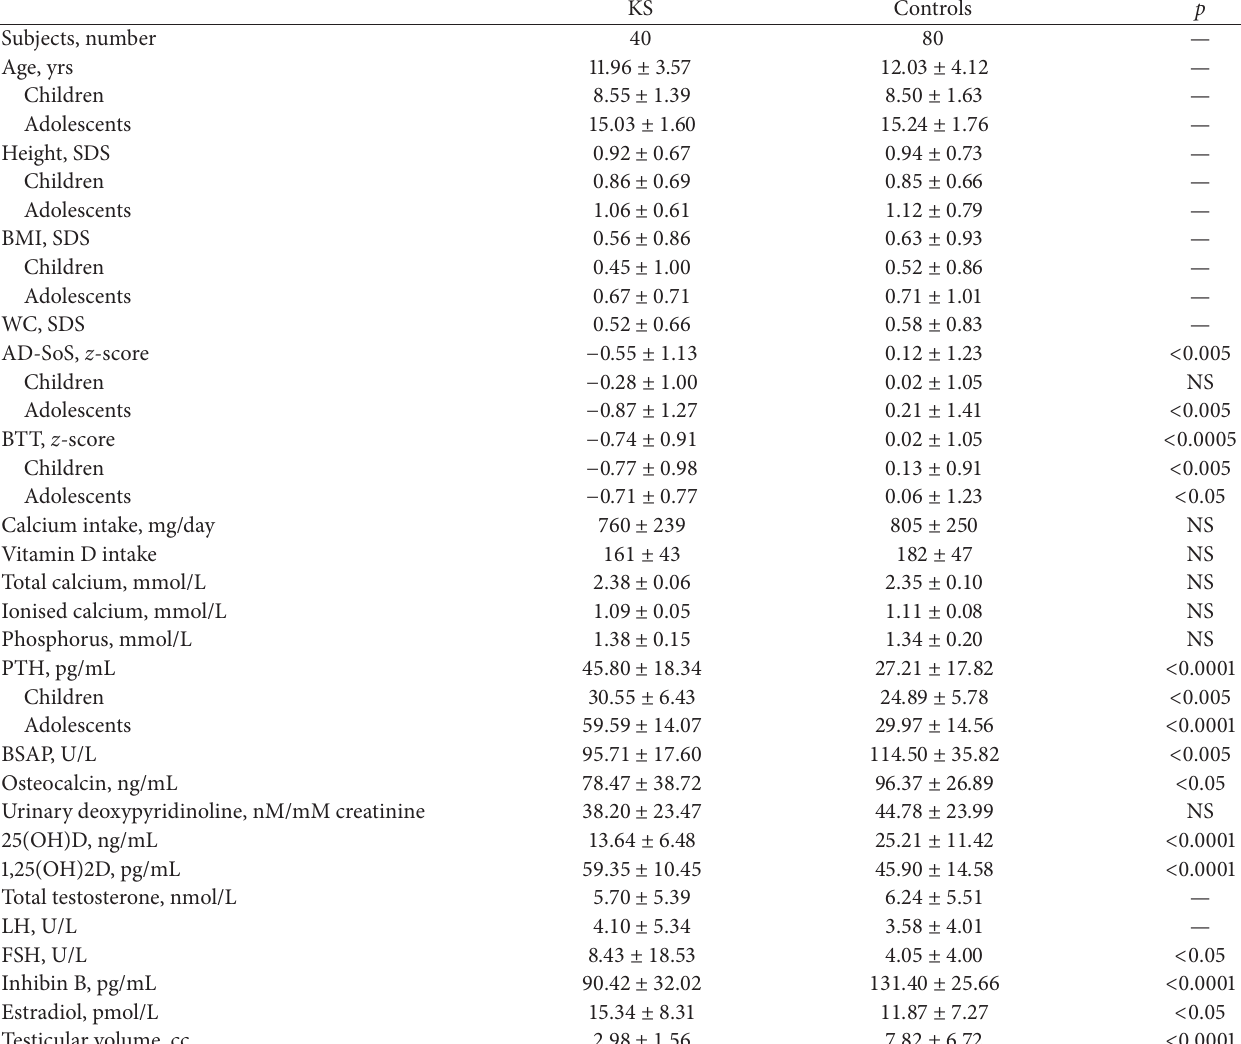
Table 1: Baseline characteristics of Klinefelter syndrome (KS) patients and